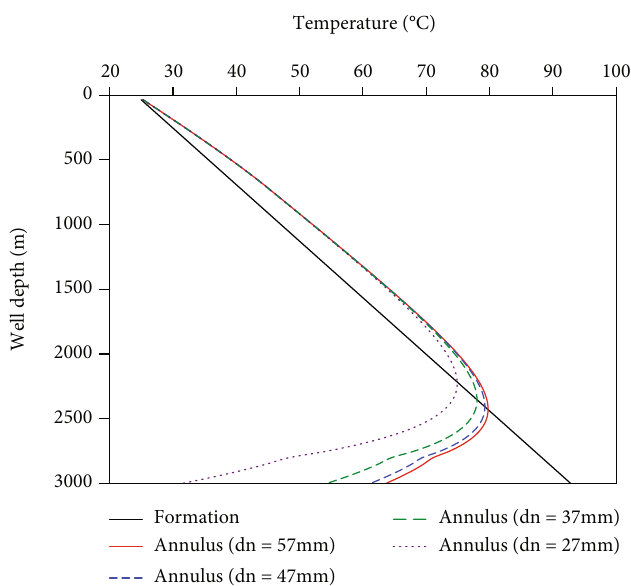
Figure 6: Variation in temperature pro fi le of the annulus with nozzles of di ff erent